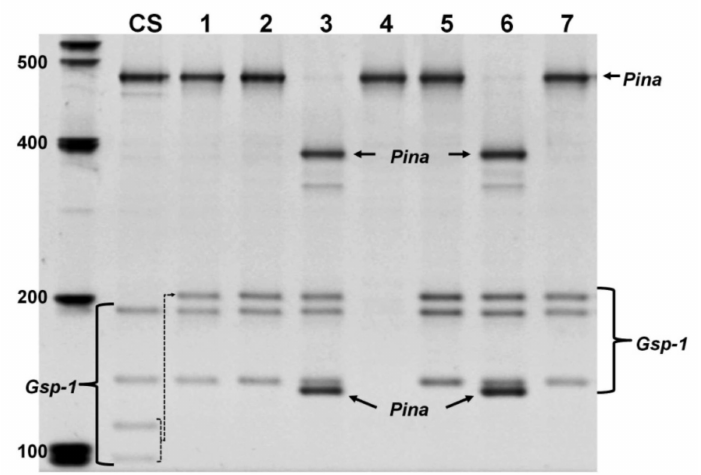
Figure 7. DNA digestion with Dde I of PCR products from Gsp-1 and Pina gene alleles of the materials evaluated. Lanes are as follows: CS , common wheat cv. Chinese Spring; 1 , PI 554559; 2 , PI 427622; 3 , PI 554504; 4 , PI 554548; 5 , PI 427453; 6 , PI 470720; and 7 , PI